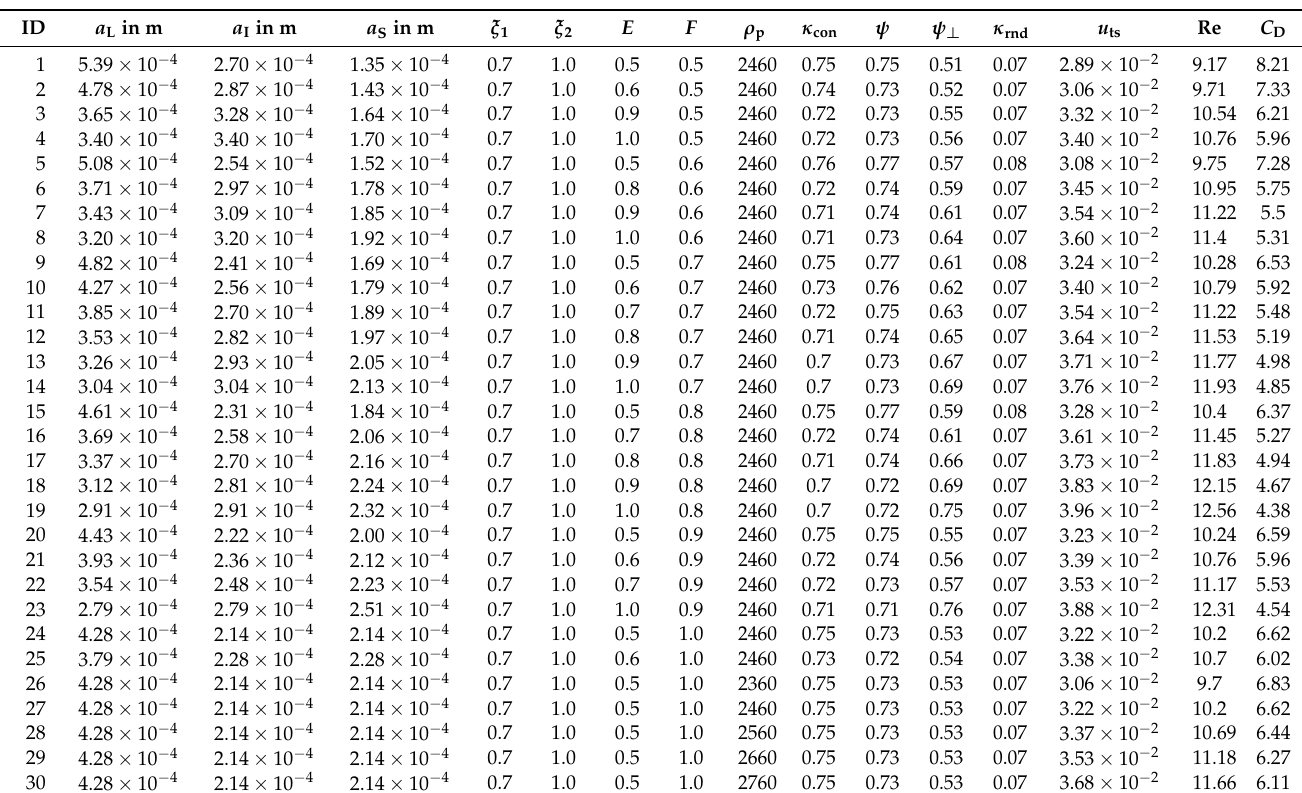
Table A6. Data of the particles in the test